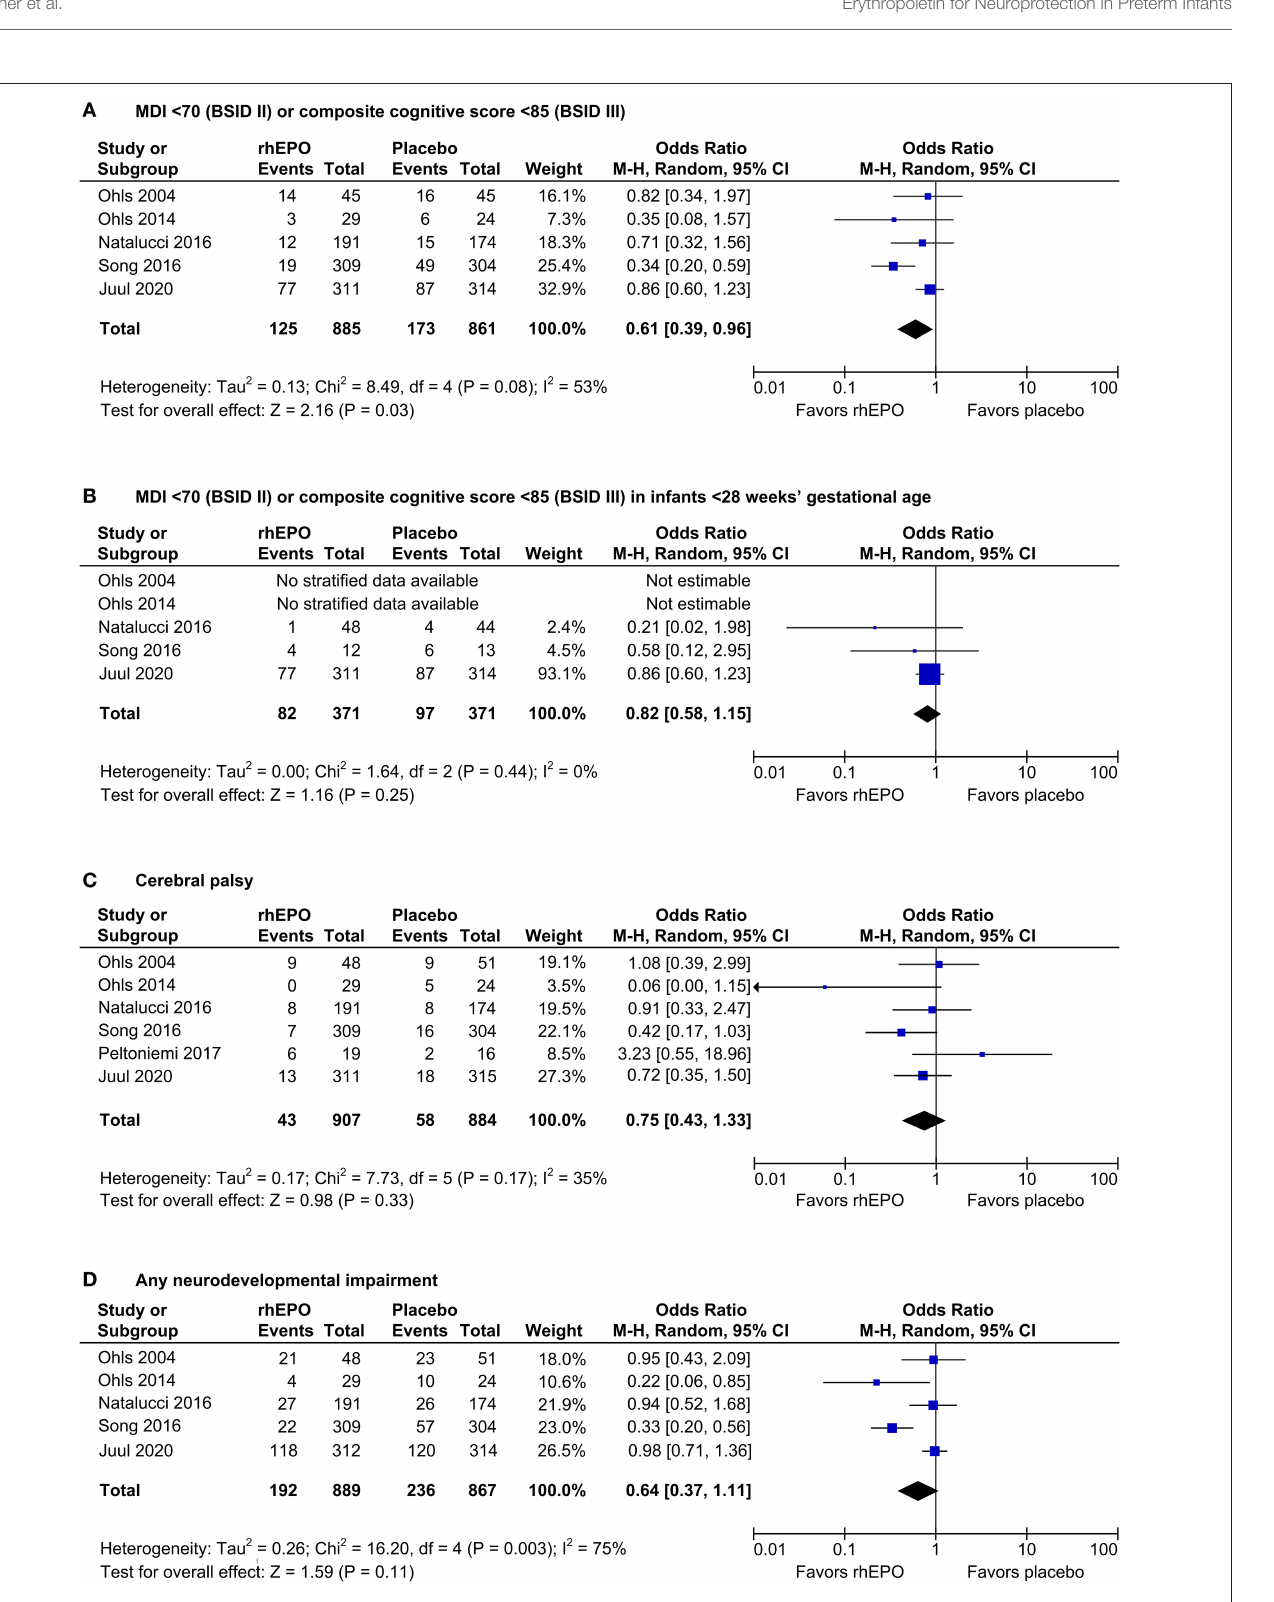
FIGURE 1 | Effects of rhEPO on neurodevelopment at 18–26 months’ corrected age. Forest plots show the effects on the number of infants with an MDI < 70 (BSID-II) or a composite cognitive score < 85 (BSID-III) in all infants (primary outcome, (A) and in infants < 28 1 / 7 weeks’ gestational age (planned subgroup analysis, (B) , on cerebral palsy (C) , and on any neurodevelopmental impairment (D) . M-H, Mantel–Haenszel.